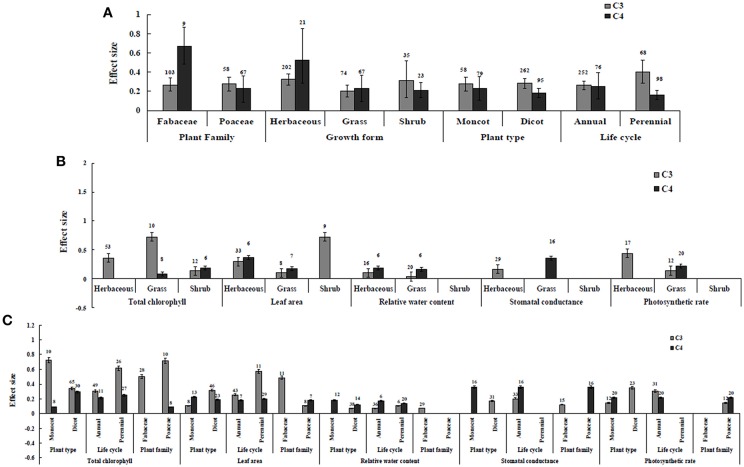
Plant functional groups-categorical analysis. (A) Overall plant functional groups response to gas exchange and water status. (B) Individual response variables reaction to plant growth form. (C) Individual response variables response to plant type, life cycle, and plant family. Error bars are means ± BS CIs. Where the CIs do not overlap each other, the effect size for a parameter is significant at P < 0.05. The number of trials included in the meta-analysis is denoted above the bar.